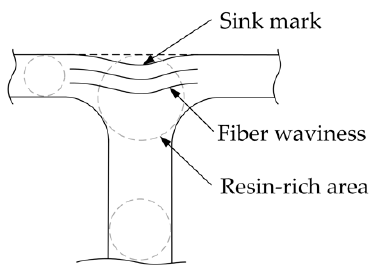
Figure 26. Shrinkage in resin-rich areas (e.g., T-joints).